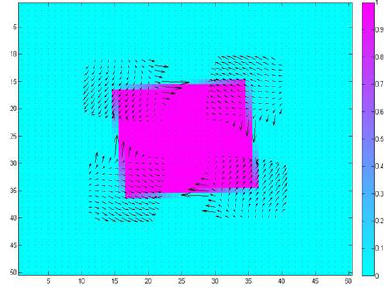
Figure 12. Results of Lucas/Kanade (Win=2,